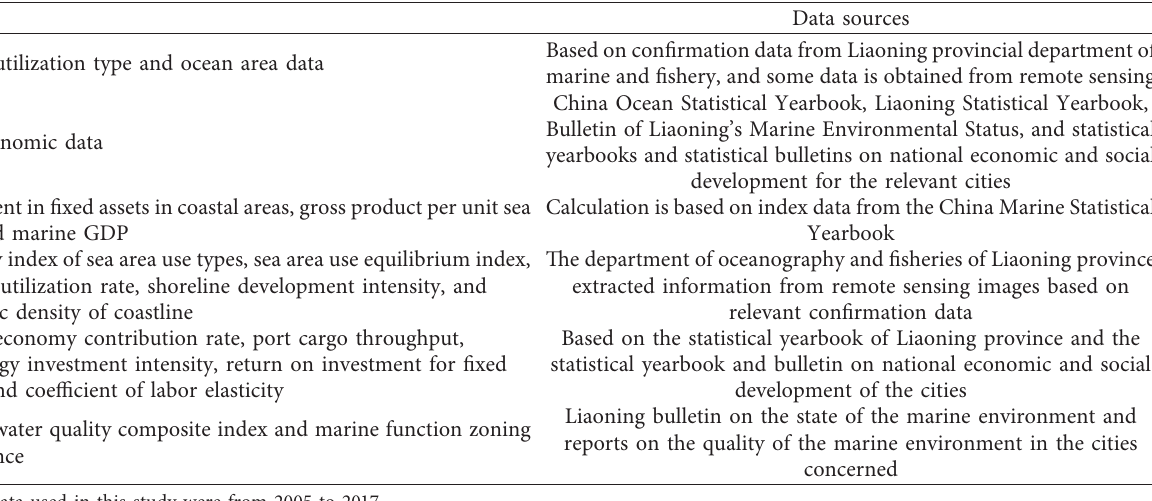
Table 1: Introduction of data and data sources.